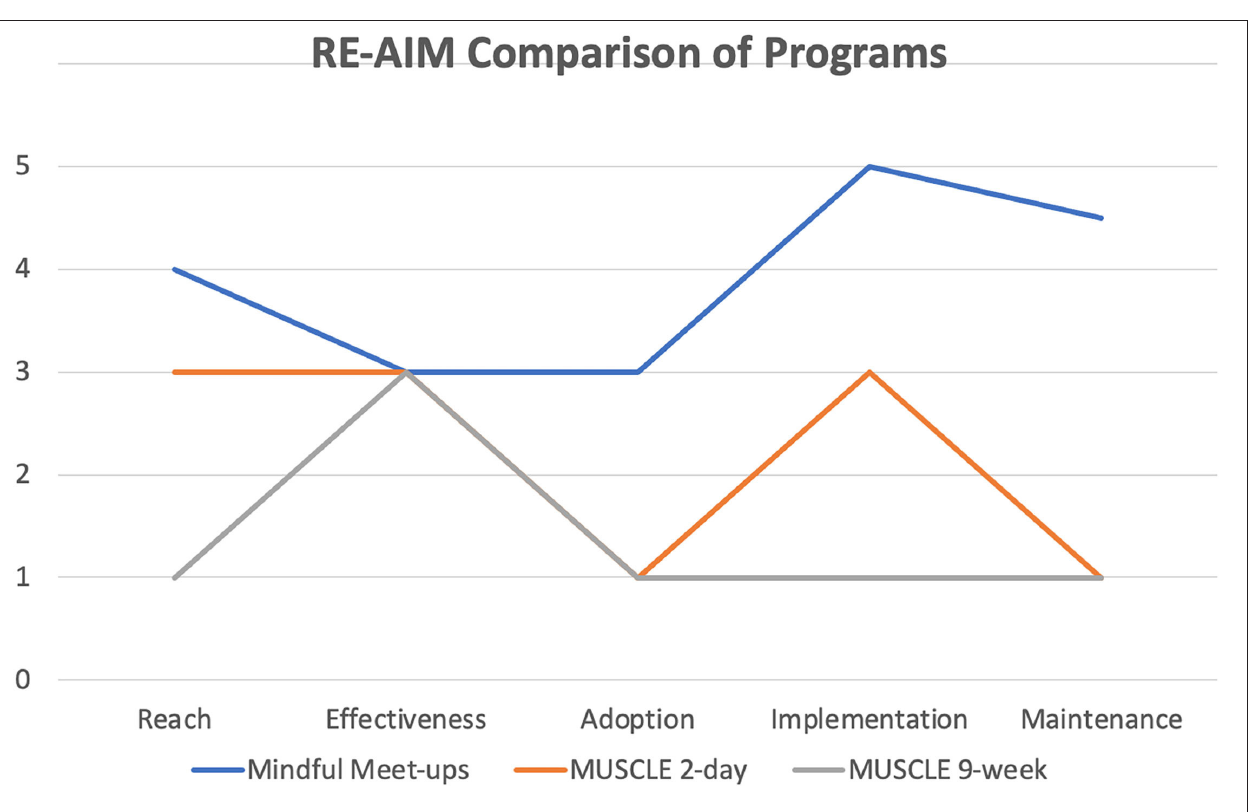
FIGURE 3 | Comparison of 3 mindfulness programs across the 5 dimensions of RE-AIM.